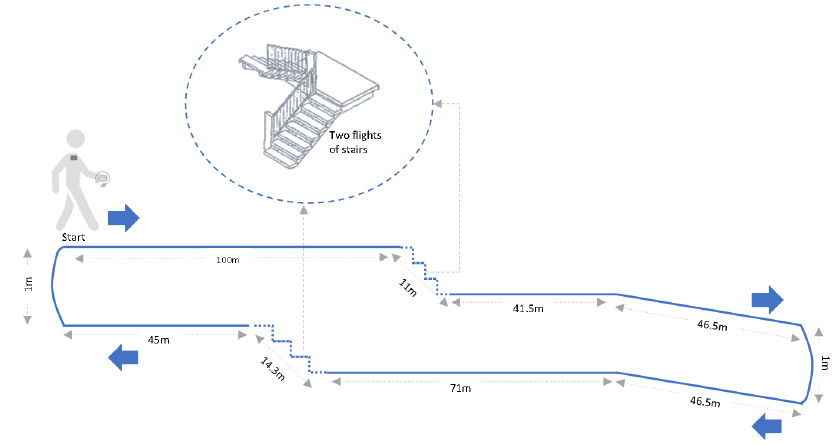
Figure 1. Route design of the 20-minute walk circuit.